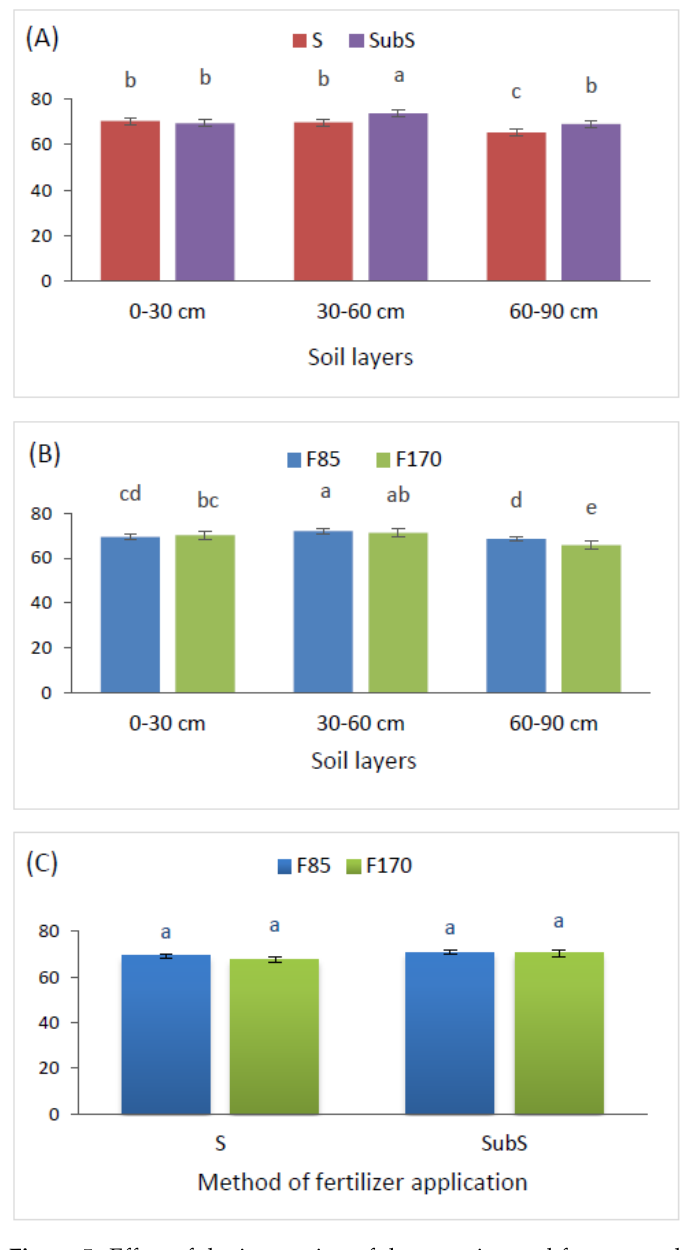
Figure 5. Effect of the interaction of the experimental factors on the soil content of available Mg [mg ∙ kg − 1 ]: ( A ) Method of fertilizer application × soil layer; ( B ) Fertilizer dose × soil layer; ( C ) Method of fertilizer application × fertilizer dose (S—Surface fertilizer application, SubS—Subsurface fertilizer application; F85—fertilizer dose 85 kg NPKS ∙ ha − 1 ; F170—fertilizer dose 170 kg NPKS ∙ ha − 1 ); different letters indicate significant difference ( p = 0.05).